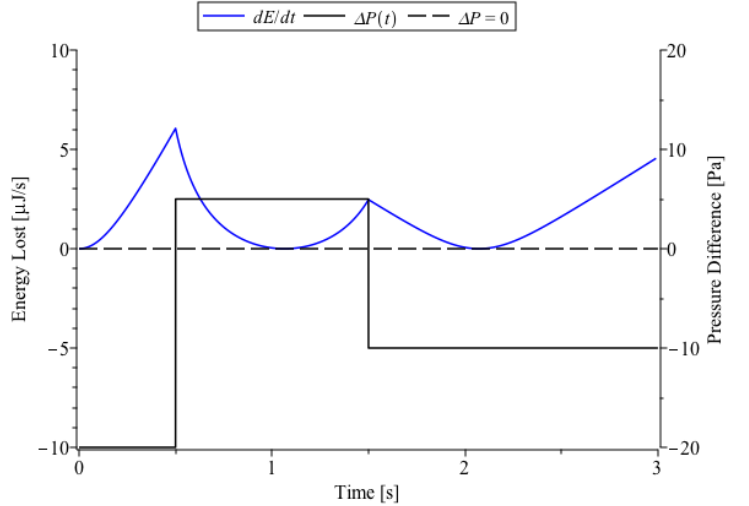
Figure 5. Theorized energy loss obtained through the CMS-Lagrangian formulation of the Raleigh– Plesset equation. Here, the energy loss is assumed to be negative and is plotted on the y-axis as per the numerical solution for the bubble radius and in accordance with Equation (53) with units on the left axis. Physical parameters were chosen to model an immersion in water: a kinematic viscosity ν L = ( 10 − 6 ) m 2 /s, density ρ L = ( 10 3 ) kg/m 3 , and surface tension γ = ( 7.2 · 10 − 2 ) N/m. A test pressure difference is also displayed, which begins at − 20 Pa, then evolves to 5 Pa, and then decreases to − 10Pa displayed against the right